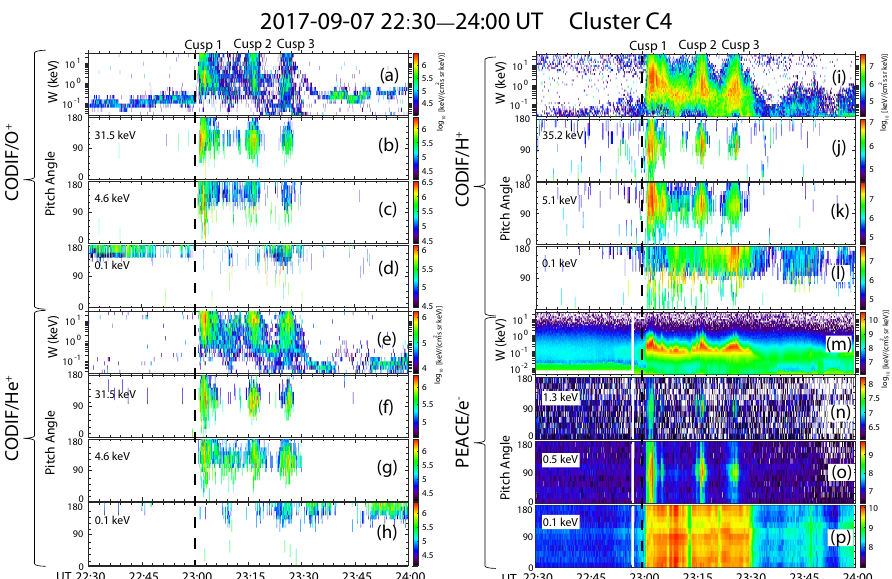
Figure 2. Pitch angle observations from the CODIF and PEACE instruments onboard Cluster C4 from 22:30 to 24:00 UT on 7 September 2017. ( a – d ) Spectrum and pitch angle distributions at three representative energy channels for O + , respectively; The same format as panels a-d except for ( e – h ) He + , ( i – l ) H + and ( m – p ) electron. The vertical dashed line represents the shock arrival time. Total magnetic and electric fields from Cluster C4 are shown in Figure 3a,b, respectively. There are strong electric field perturbations even up to 40 mV/m inside Cusp 1, which are comparable to those related to the shock impact around 23:01 UT. The RAPID instrument MeV [36,37]. Figure 3c–h display the energy flux (keV/(cm 2 · s · sr · keV)) of different ions in